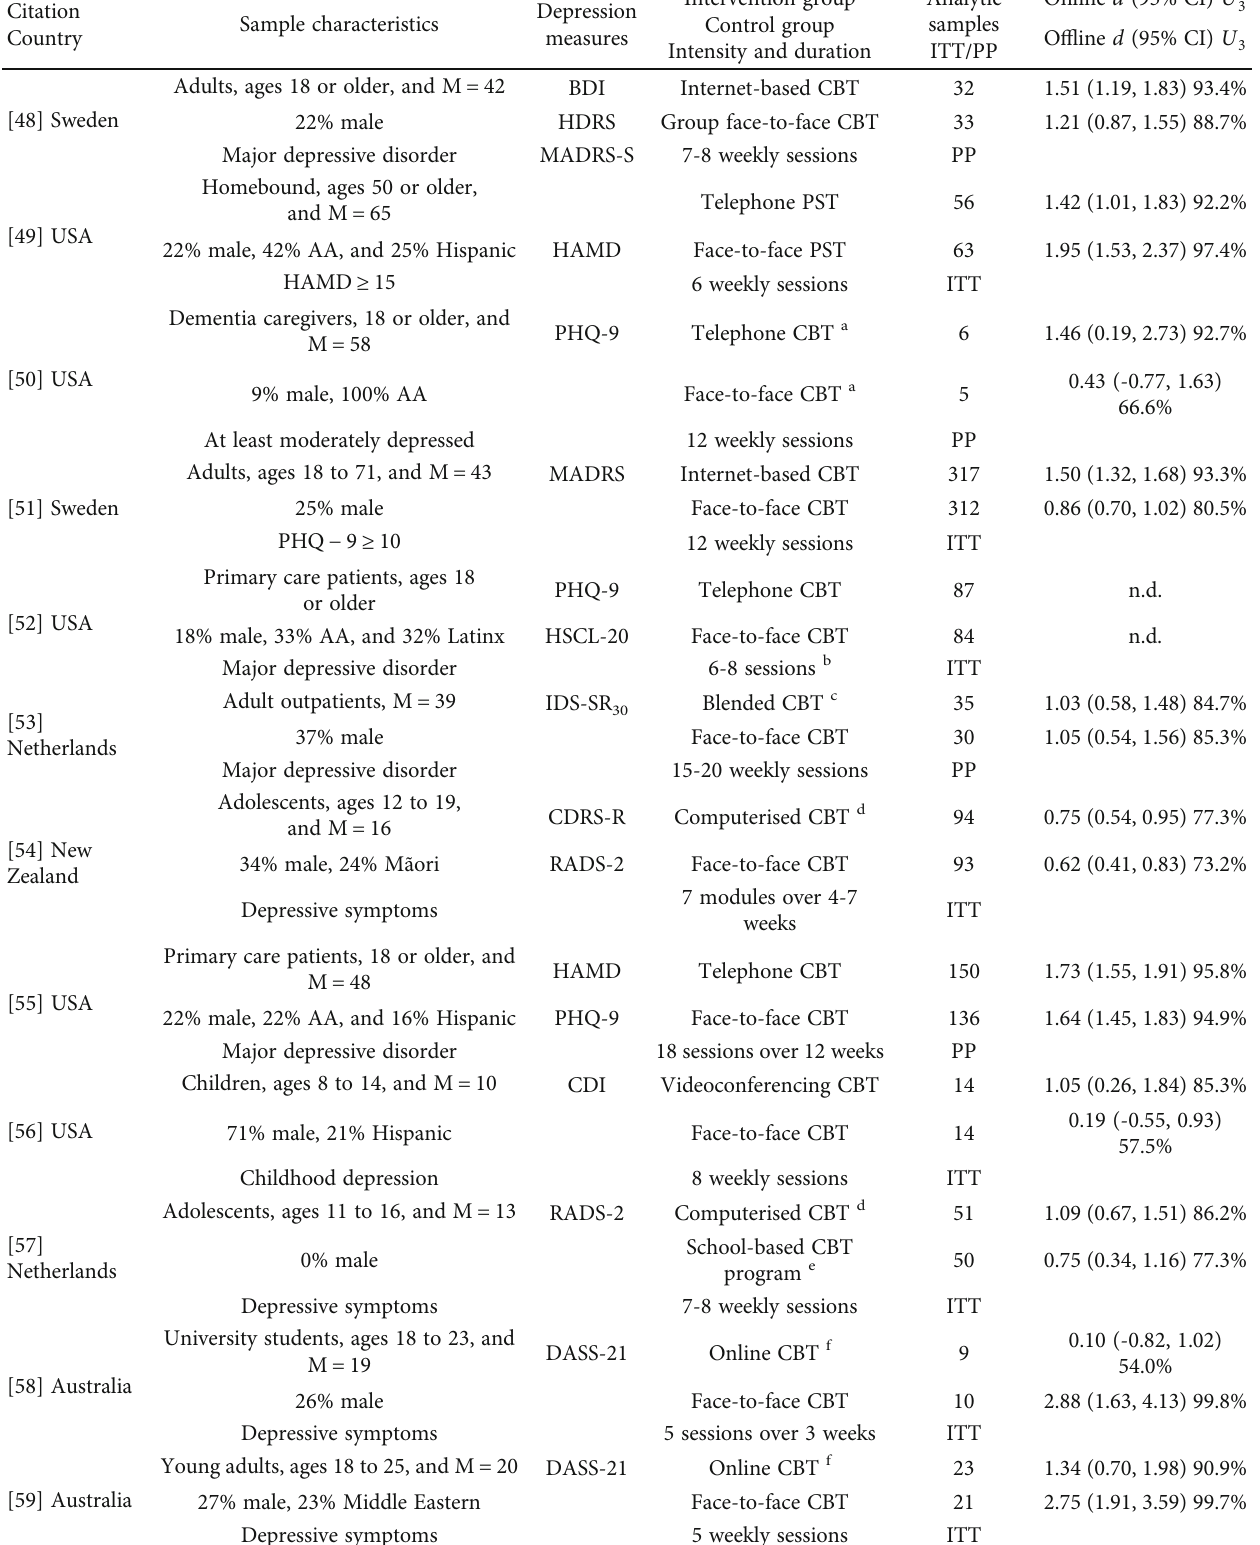
Table 1: Description of 17 studies included in the meta-analysis with within-group improvement rates at posttest.